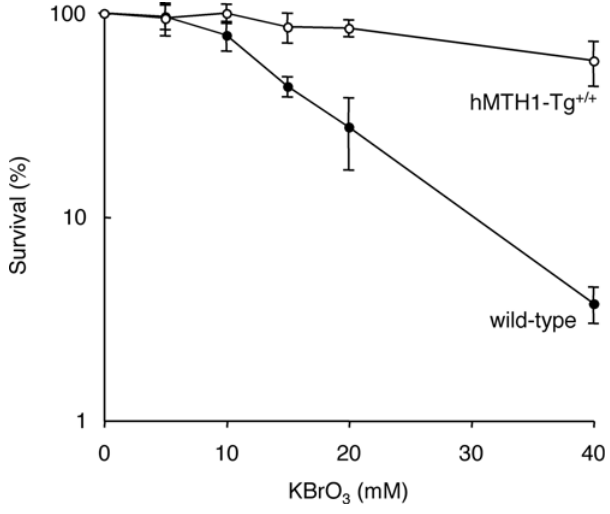
Figure 3. KBrO 3 sensitivity of hMTH1-Tg + / + and wild-type MEFs. Wild-type (closed symbols) and hMTH1-Tg + / + (open symbols) MEFs were treated with KBrO 3 for 30 min at the indicated concentrations. Viability was measured by MTT assay 48 hr later. The graphs are the mean 6 SD of 3 independent experiments.